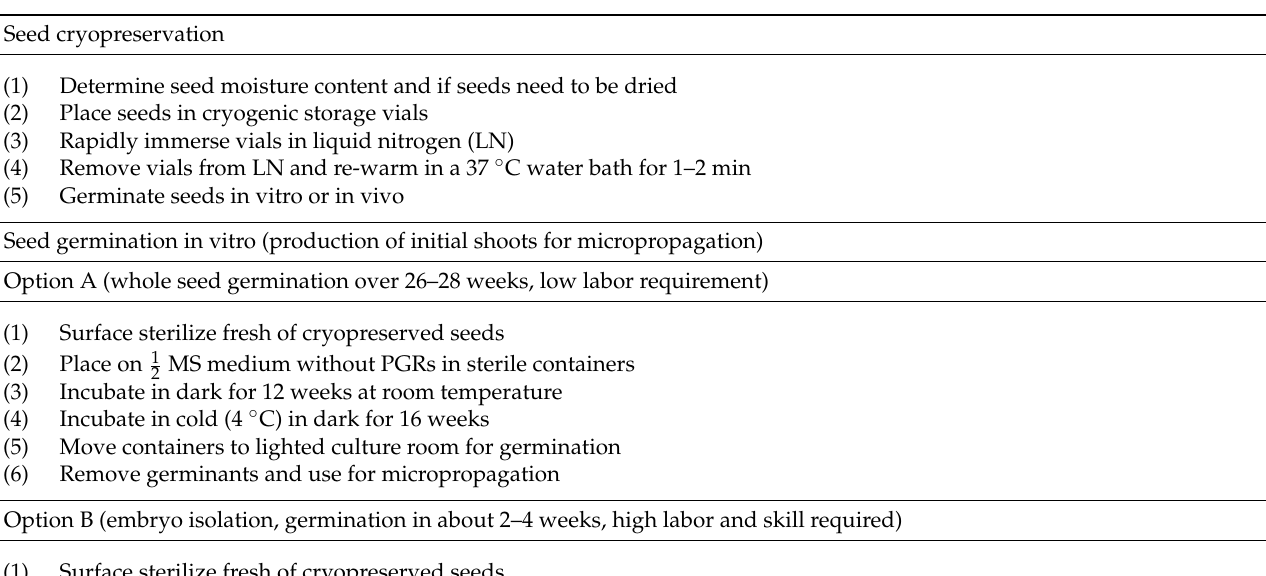
Table 11. Recommended steps for Xerophyllum asphodeloides seed cryopreservation, germination of isolated embryos or seeds and growing